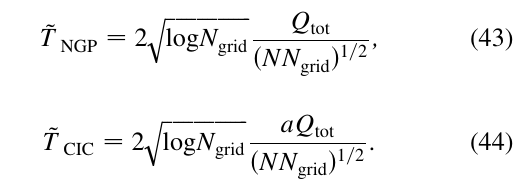
(cid:4) 64 and N (cid:4) 1 (third column); N (cid:4) 64 and i i ppg (dashed lines) and ~ T (solid NGP NGP